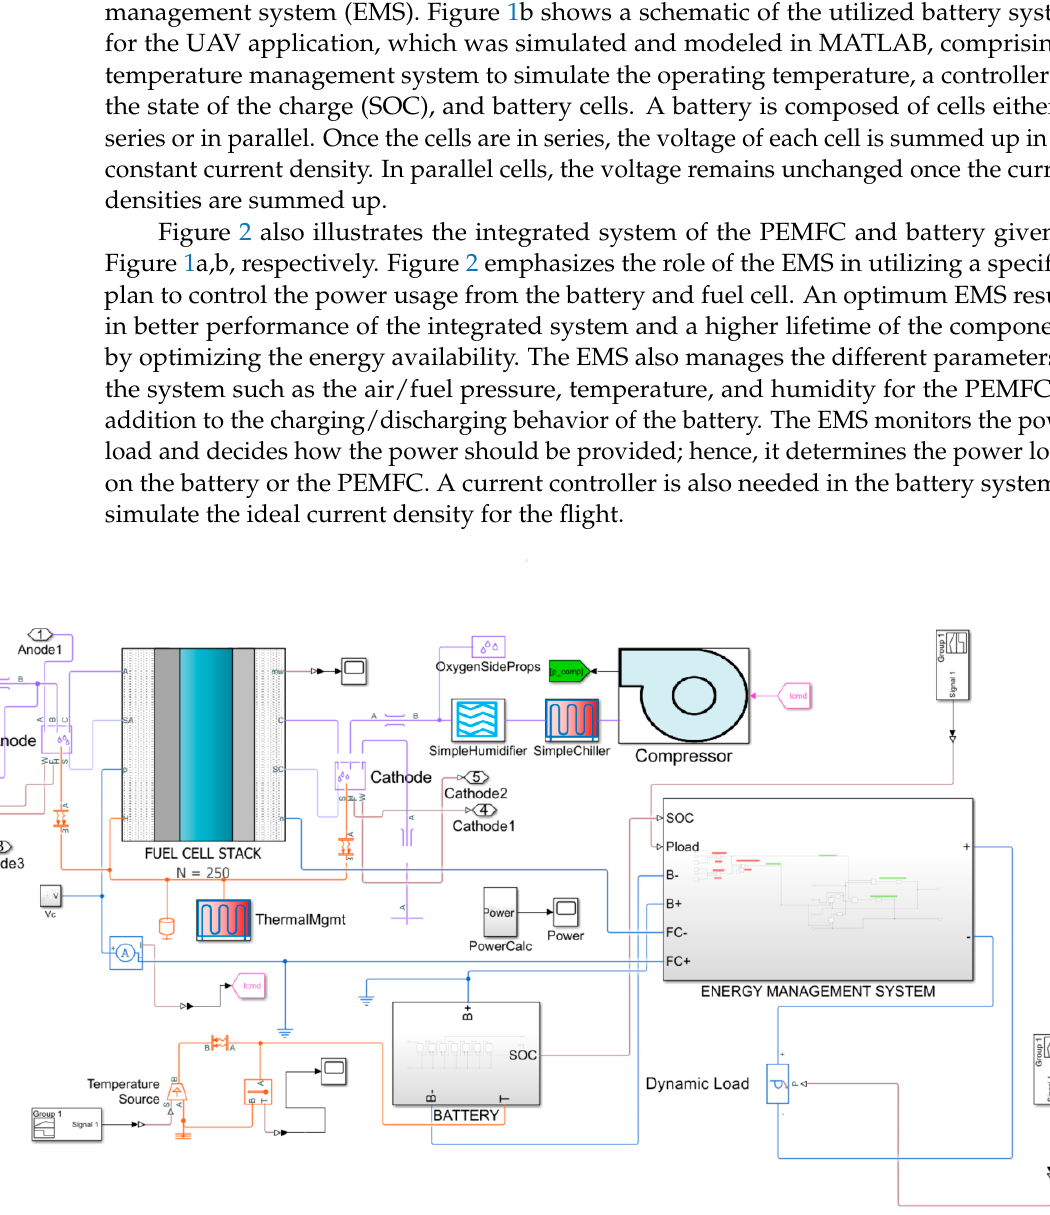
Figure 2. The proposed hybrid system of fuel cell and battery for the UAV application.